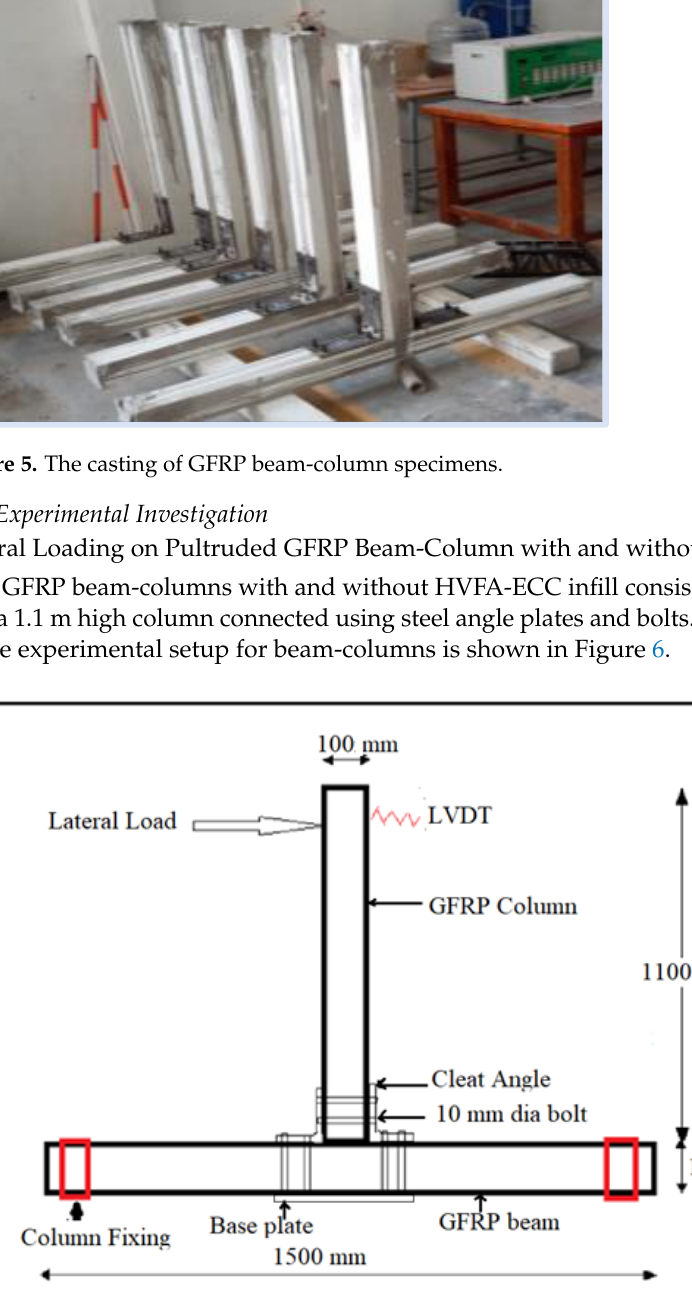
Figure 7. Experimental setup for lateral loading on beam-columns. 3. Results and Discussion 3.1. Lateral Load – Deformation Behavior The failure of the GFRP beam-column without HVFA-ECC infill was sudden, but the failure of GFRP sections infilled with HVFA-ECC was in a sequential manner and exhib- ited a larger load-carrying capacity due to the confinement effect provided by ECC with the GFRP section. The failure pattern of the beam-column specimens is shown in Figure 8.